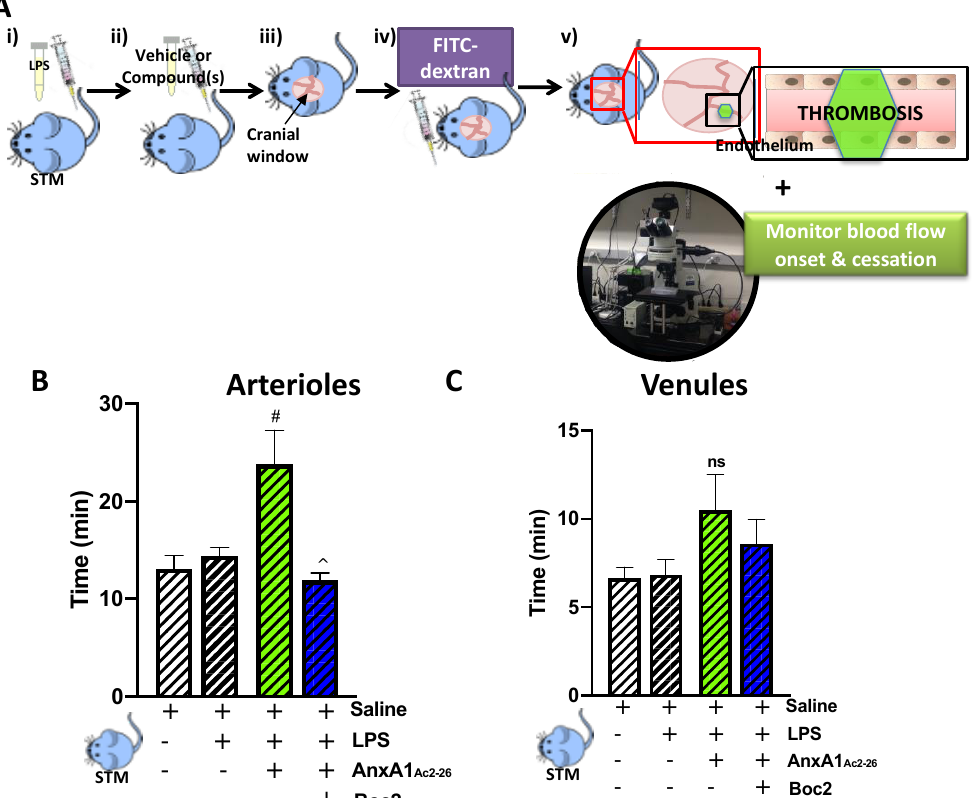
Figure 4. AnxA1 Ac2-26 affords arteriolar protection against cerebral inflammation-induced thrombosis in sickle cell transgenic mice (STM). ( A ) schematic showing the experimental protocol: (i) STM were subjected to vehicle (saline) or LPS (0.4 mg / kg) for 2 h and (ii) treated with vehicle (saline) or compound(s): AnxA1 Ac2-26 (4 mg / kg) with / without pan FPR antagonist Boc2 (0.4 mg / kg) 20 min prior to thrombosis. (iii) A cranial window was performed and (iv) FITC-dextran was injected (10 mg / kg of 5%). (v) Mice were subjected to intravital microscopy and light / dye-induced thrombus formation, with onset and blood flow cessation times recorded for cerebral ( B ) arterioles and ( C ) venules. Data are means ± SEM of 5–6 mice / group. # p < 0.05 vs. LPS group. ˆ p < 0.05, vs. LPS + AnxA1 Ac2-26 group. ns—non-significant vs. corresponding LPS group.